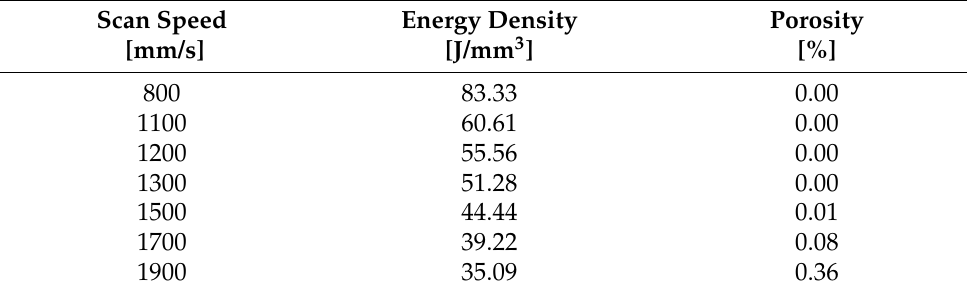
Table 3. Numerical results of the porosity simulations for different velocities.